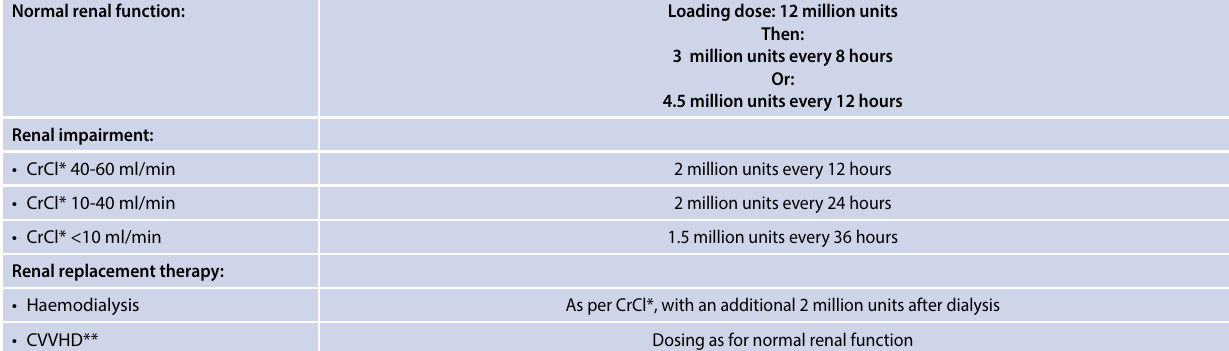
Table 1: Recommended adult dosages of IV colistin (CMS) in critically-ill patients Normal renal function: